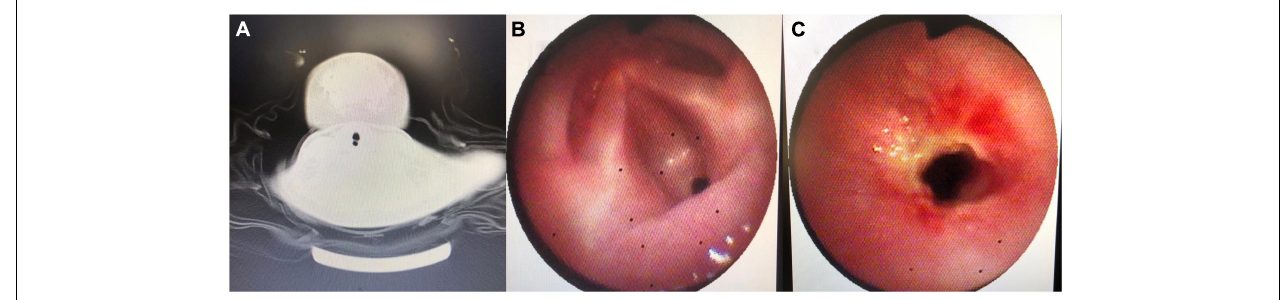
FIGURE 1 | (A) Neck CT noting linear diaphragm in glottis. (B) Image from the first bronchoscopy: webbed connection covering the anterior commissure of glottis and blocking nearly two thirds of glottis. (C) Image from the second bronchoscopy: a small amount of yellow necrotic material attaching to the anterior commissure of